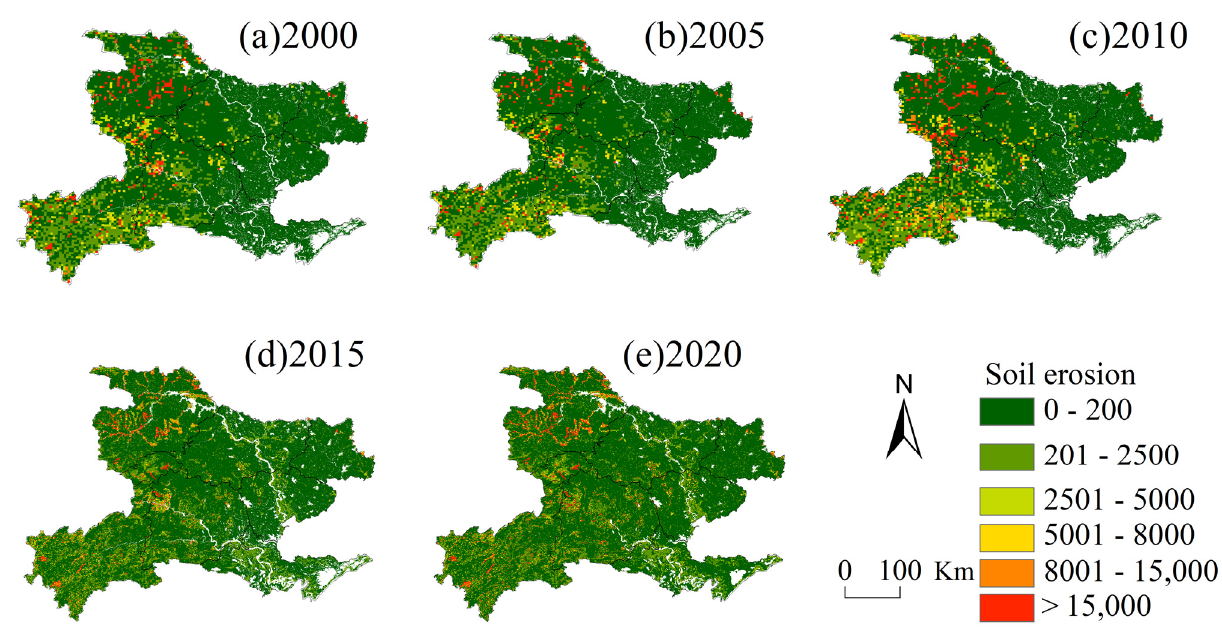
Figure 6. Soil erosion map of western Hubei Province in ( a ) 2000, ( b ) 2005, ( c ) 2010, ( d ) 2015, ( e ) 2020 (t·ha − 1 ·yr − 1 ).